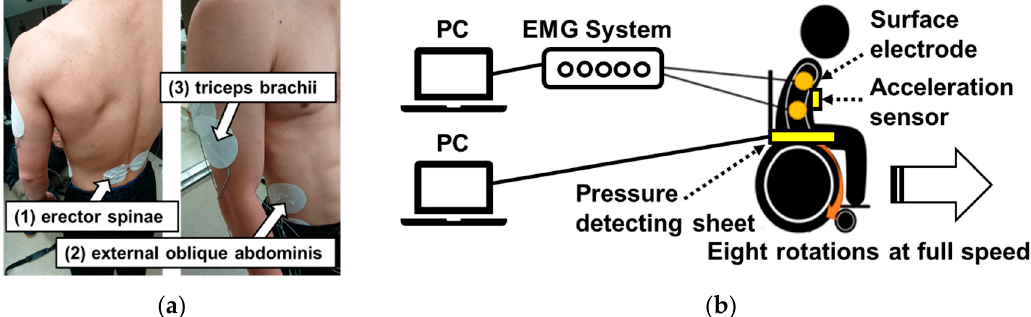
Figure 4. Measurement position of sEMG and schematic diagram II: ( a ) three measurement points and ( b ) schematic diagram showing the experiment.